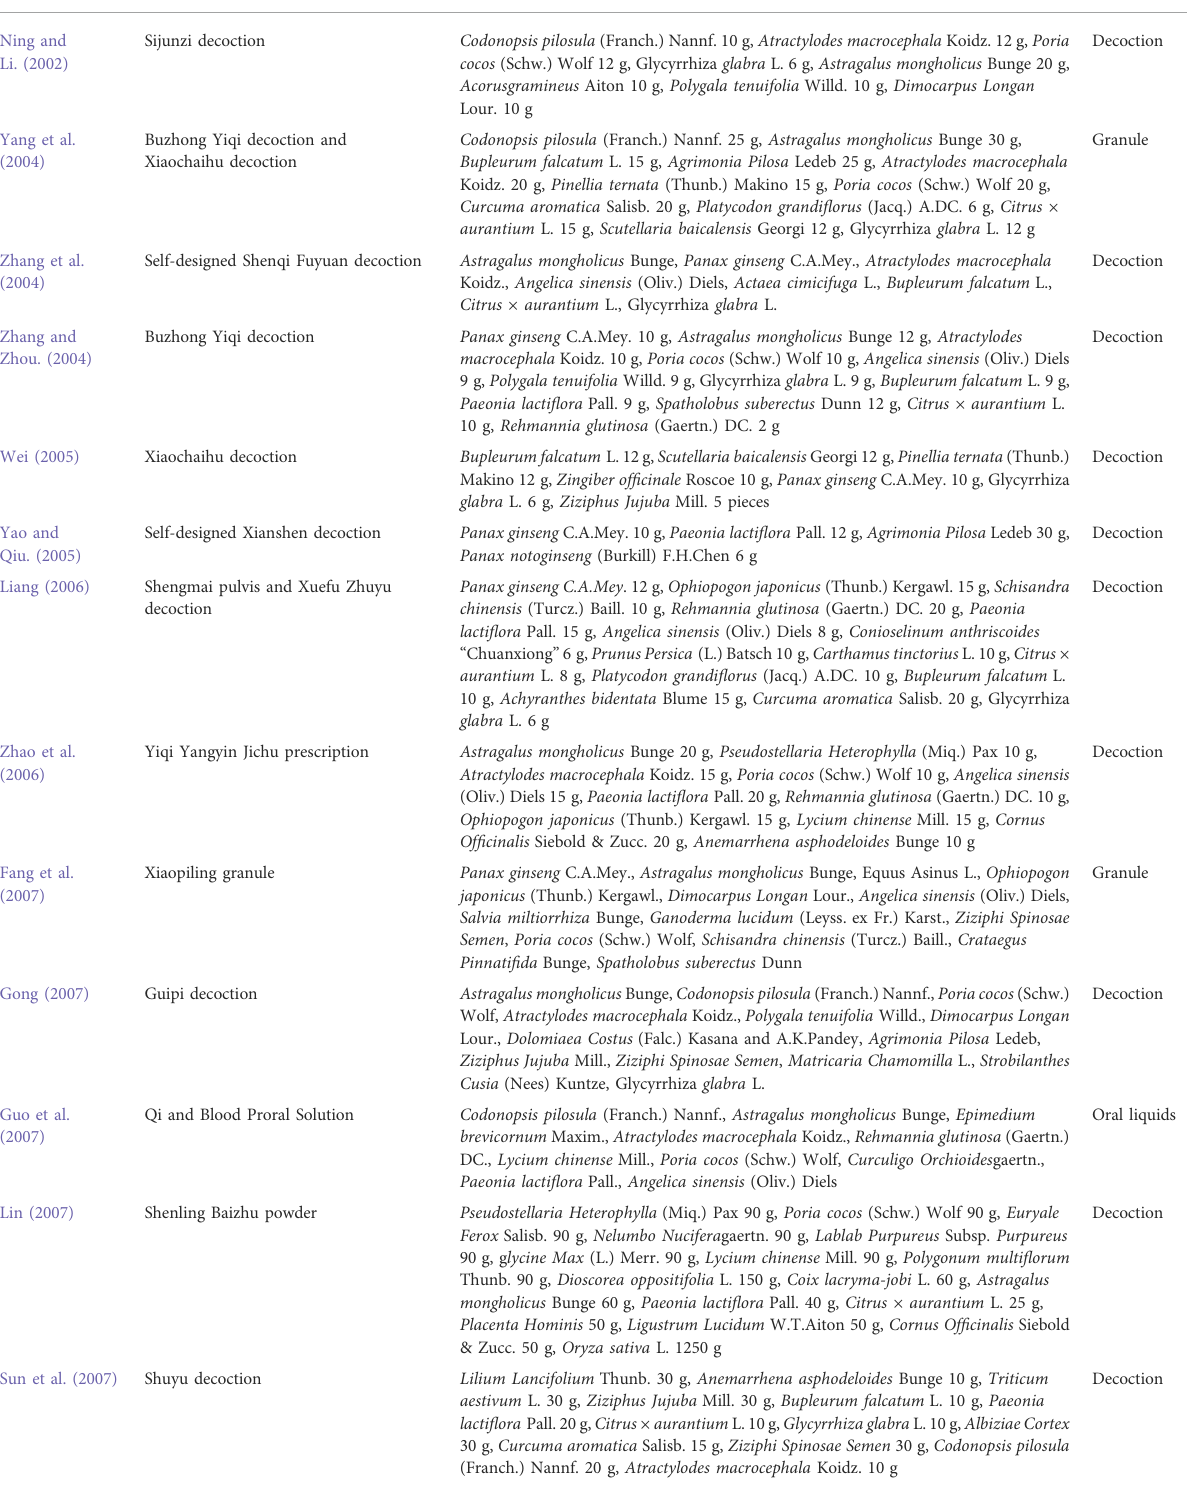
TABLE 2 Components of Chinese herbal medicine used in the included